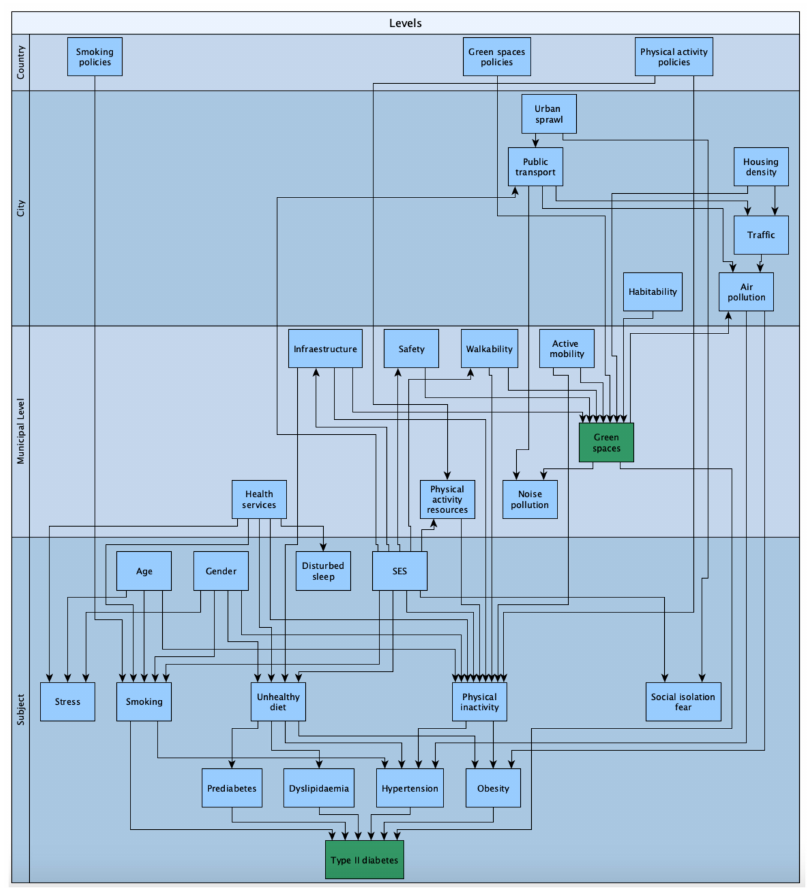
Figure 1. Scheme of multilevel dependency on green-space exposure and related variables. Source: own